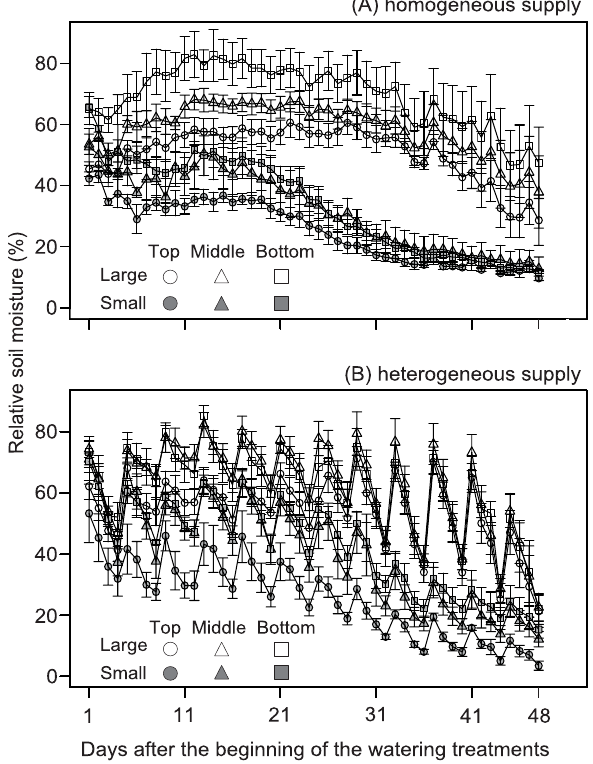
Figure 1. Mean relative soil moisture ( 6 SE). (A) heterogeneous supply treatments; (B) homogeneous supply treatments; Top, middle, bottom: top, middle, and bottom zone treatments, respectively. Large, large water volume supply; Small, small volume supply. The soil moisture content was larger with a large water volume than a small volume. The soil moisture content in the bottom zone was the largest, and that in the top zone the smallest. The temporal variability in soil moisture content under heterogeneous water-supply conditions was larger than that under homogeneous conditions.